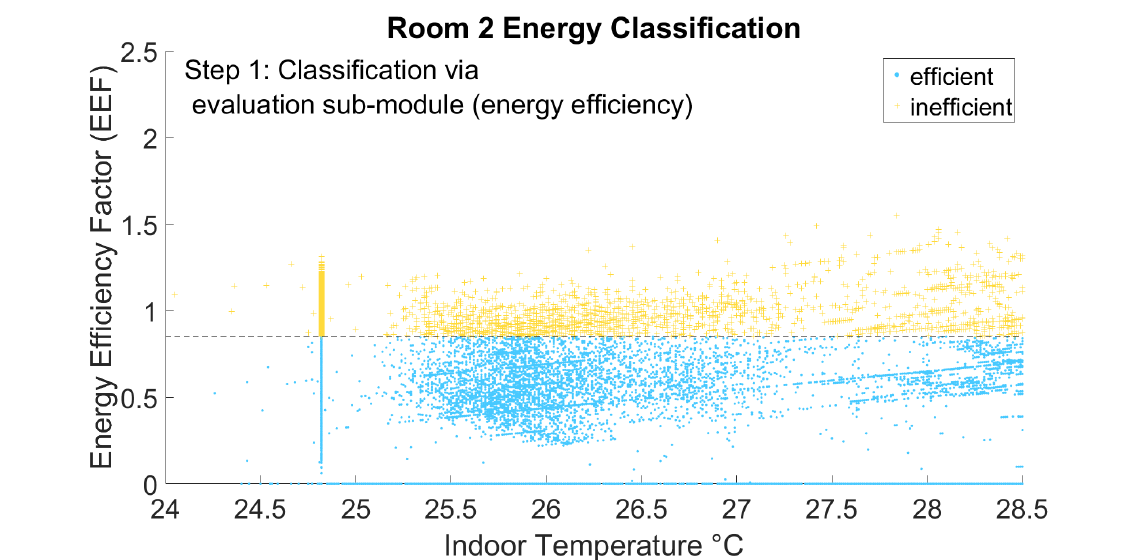
Figure 4. Classification of energy-efficient and energy-inefficient behavior based on inference rules in the evaluation sub-module for Room-2.